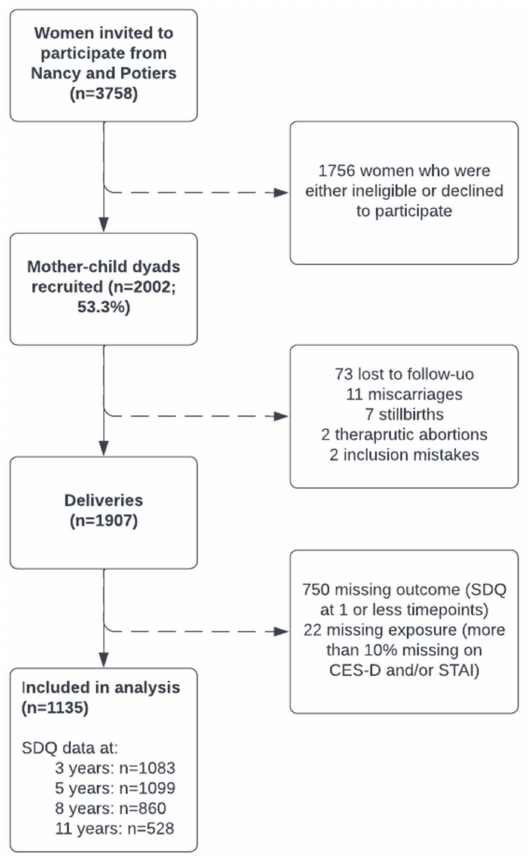
Figure 1. Flowchart of the study sample